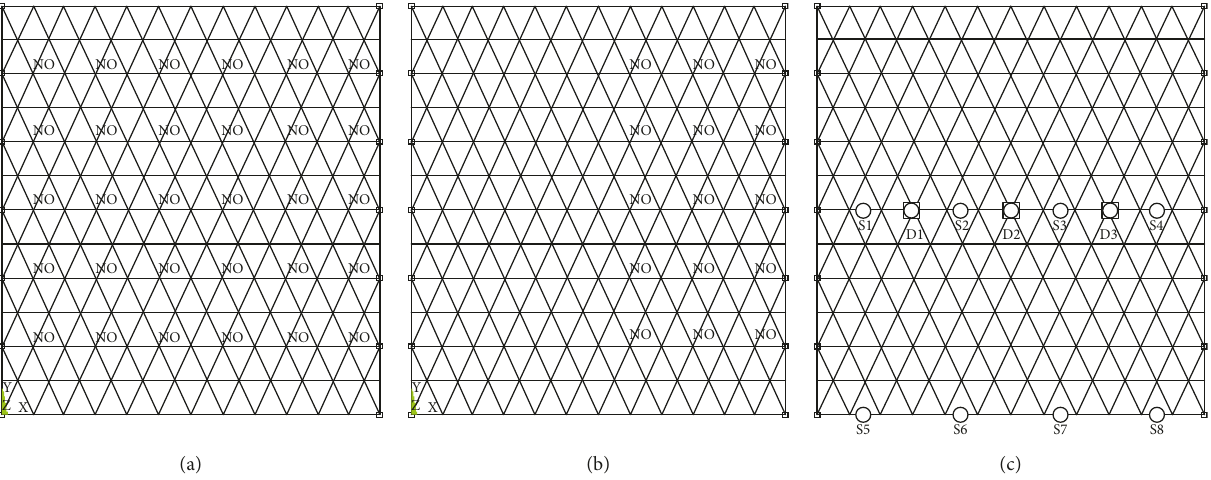
Figure 16: Layout of the sensors and loads on the CSBV. (a) Distribution of the hanging sandbags in the full span. (b) Distribution of the hanging sandbags in the half span. (c) Layout of the sensors on the